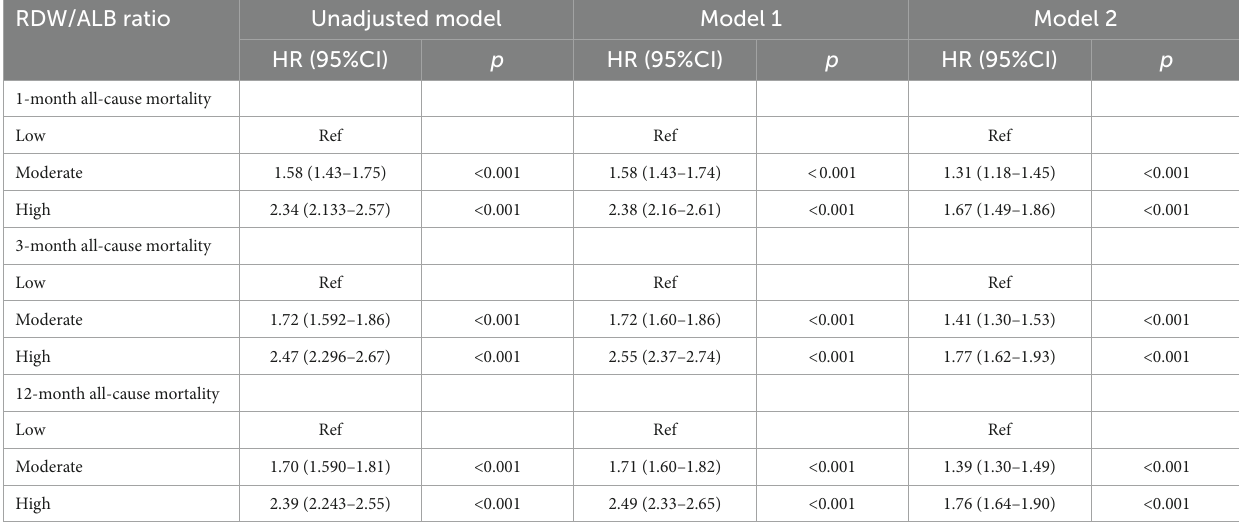
TABLE 3 Hazard ratios (HRs) for all-cause mortality based on RDW/ALB ratios in acute kidney injury (AKI) patients.